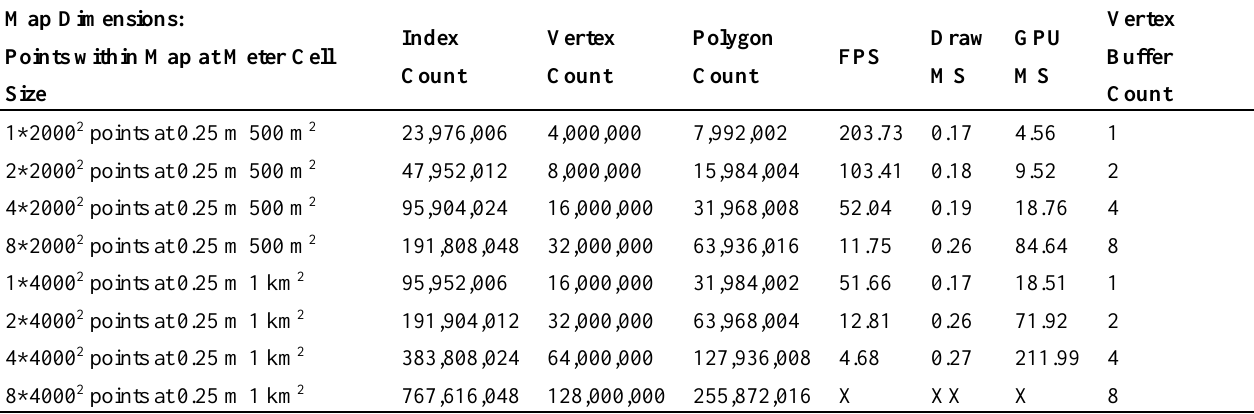
Figure 11. Graph showing the correlation between frames per second and polygon count of single vertex buffers. Table 5. Runtime evaluation of visualised terrains at multiple resolutions with multiple vertex